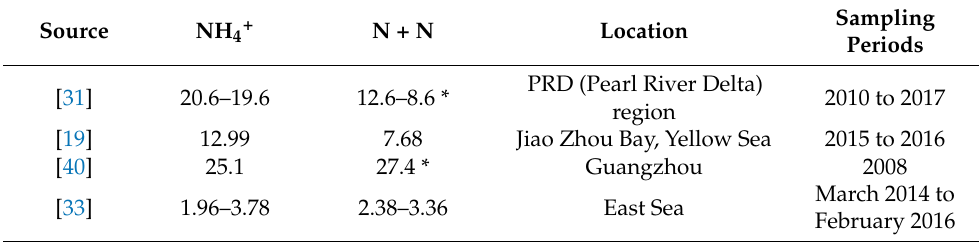
Table 2. Wet N deposition in different location.